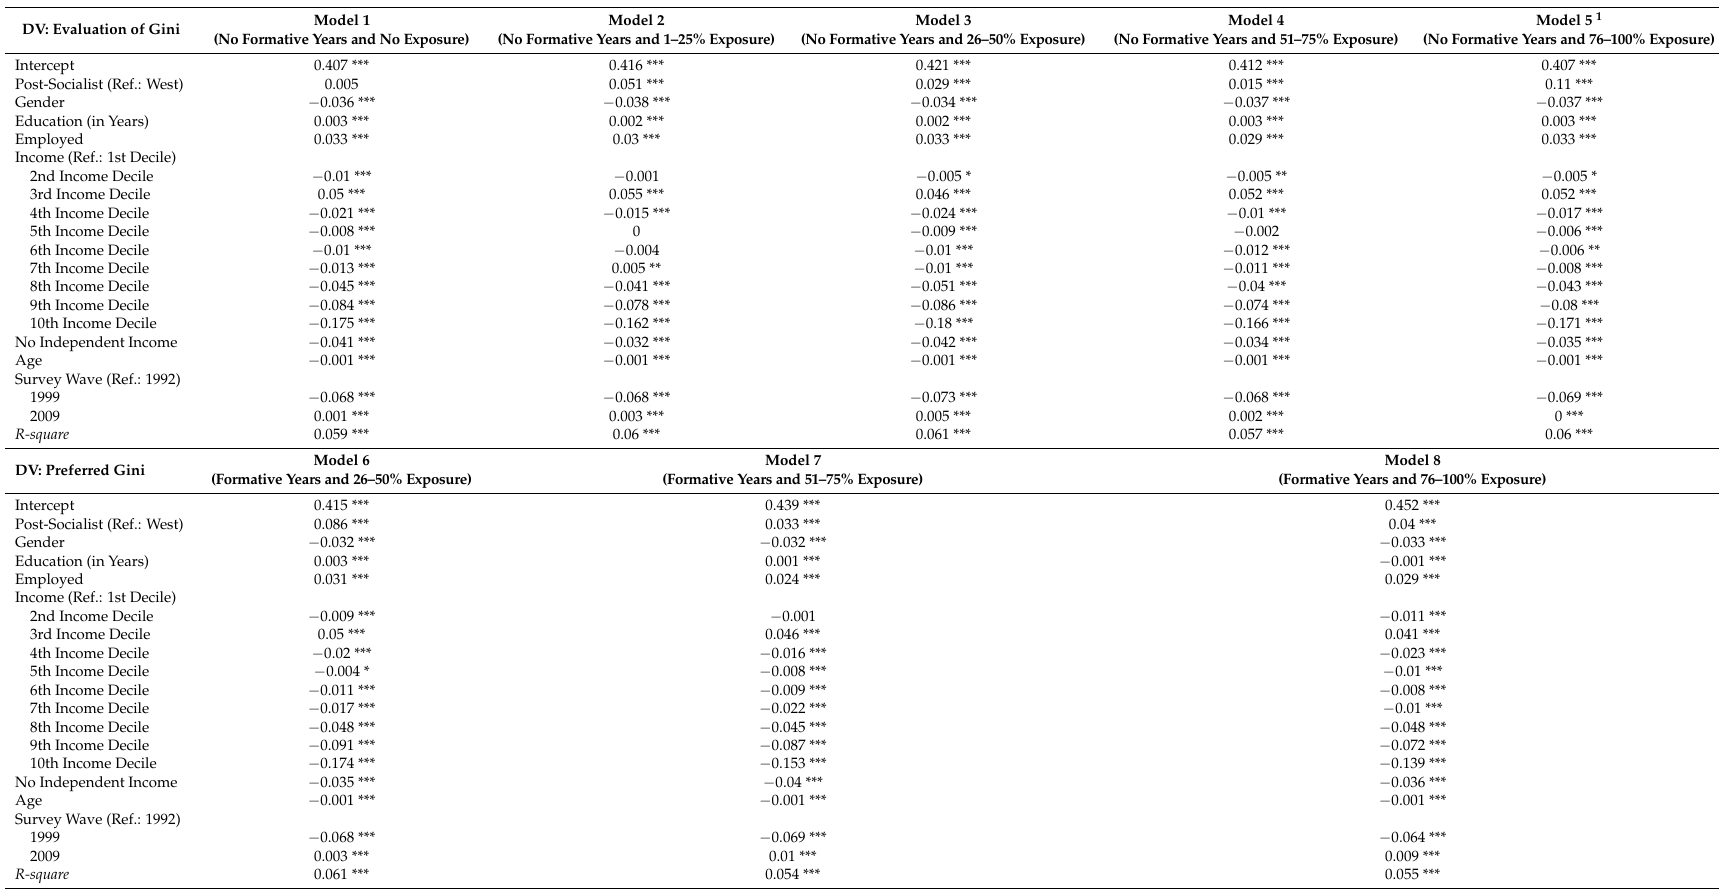
Table A6. Bootstrapped OLS regression models to explain the evaluation of Gini by exposure rate and formative years (corresponding with Figure